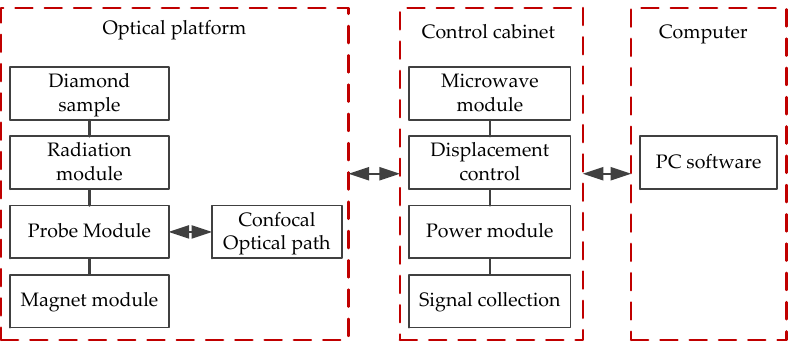
Figure 19. Block diagram of the quantum diamond single-spin spectrometer system.